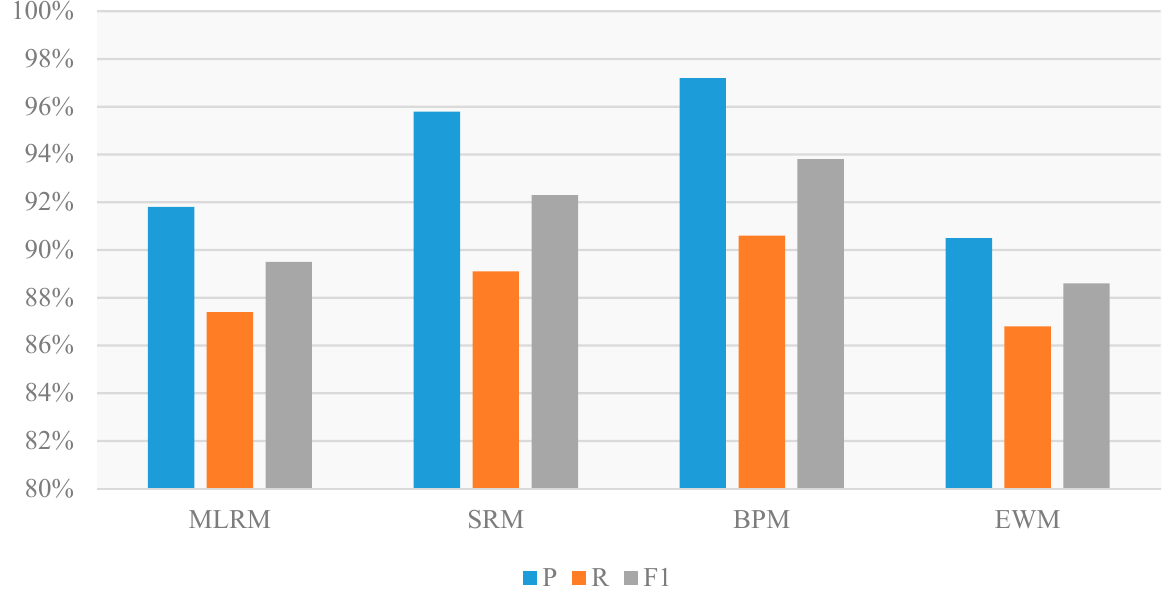
Figure 8. Comparison of P (Accuracy), R (Recall), and F 1 (F1-Measure evaluation) of the four matching models, multi- variate logistic regression matching model (MLRM), SVM regression matching model (SRM), Matching Model Based on Backpropagation Neural Network (BPM), and empirical weight matching model